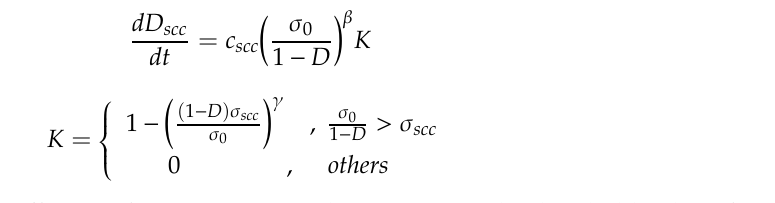
Figure 6. Corrosion fatigue fracture morphology. ( a ) Corrosion pit evolution diagram; ( b ) Steel wire fracture diagram near corrosion pit.